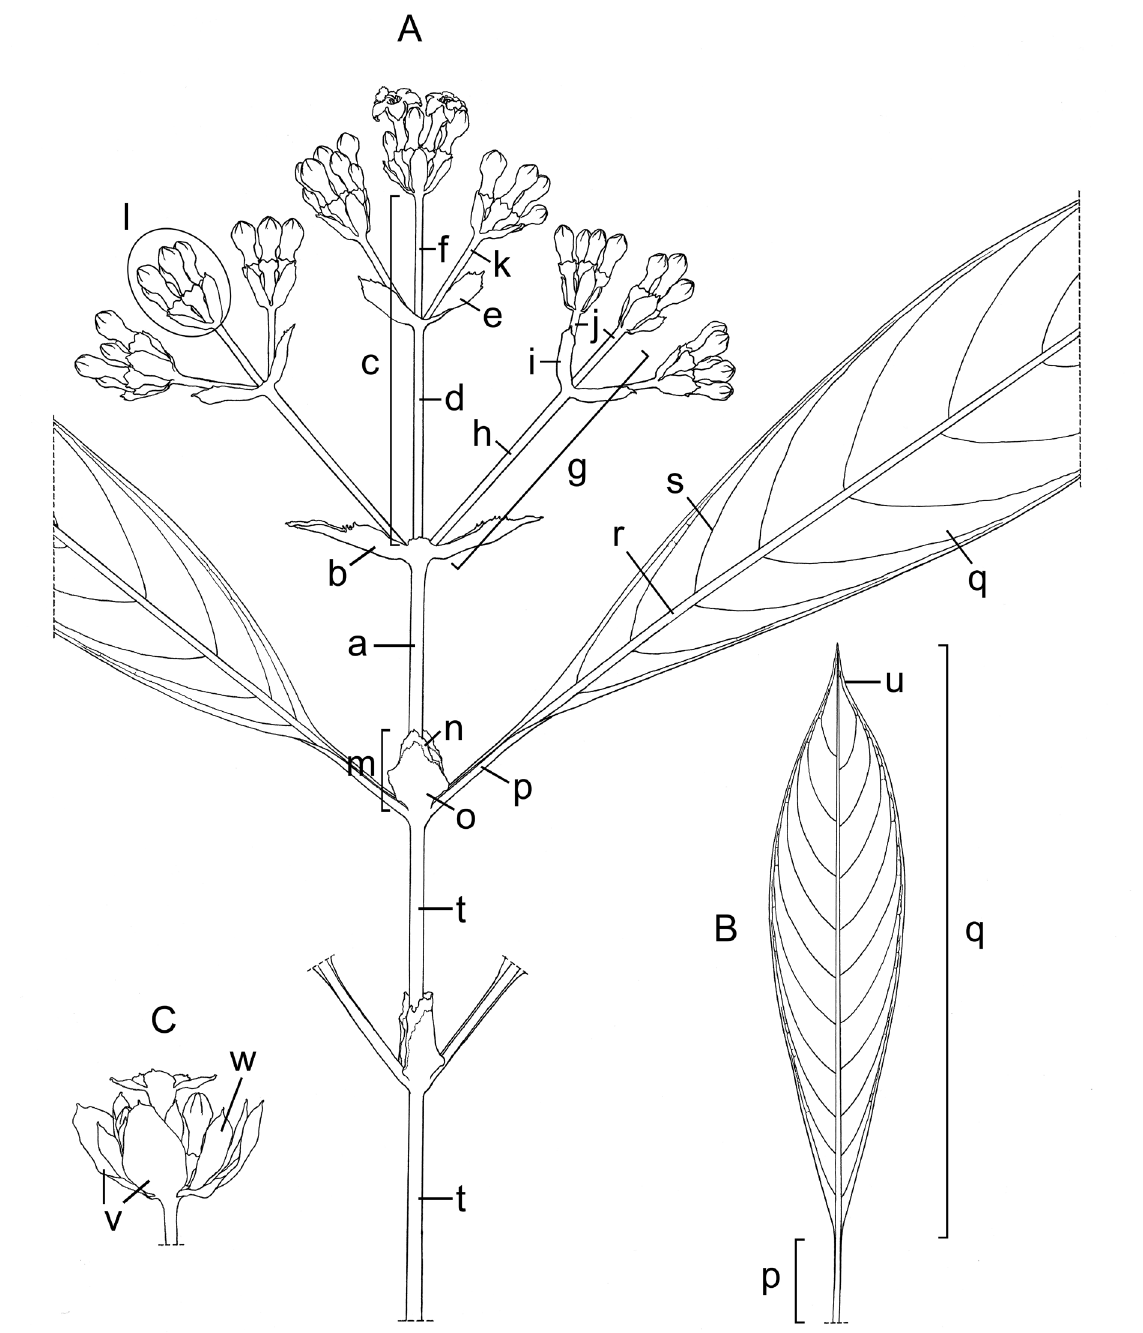
Fig. 2. Morphological glossary of Chassalia Comm. ex Poir. in Borneo; A–B = C. kinabaluensis T.Y.Yu sp. nov.; C = C. chewii T.Y.Yu sp. nov. A . Shoot with terminal inflorescence. B . Leaf. C . Capitulum. a = peduncle; b = bract subtending first internode of rachis; c = rachis; d = first internode of rachis; e = bract subtending second internode of rachis; f = second internode of rachis; g = first branch; h = first internode of first branch; i = bract subtending second internode of first branch; j = second internode of first branch; k = second branch; l = capitulum; m = stipule; n = apical (chaffy) part of stipule; o = basal (membranous) part of stipules; p = petiole; q = leaf-blade; r = midrib; s = secondary nerve; t = internode; u = acumen; v = outer (capitular) bracts; w = inner (capitular) bract. Drawn by T.Y.